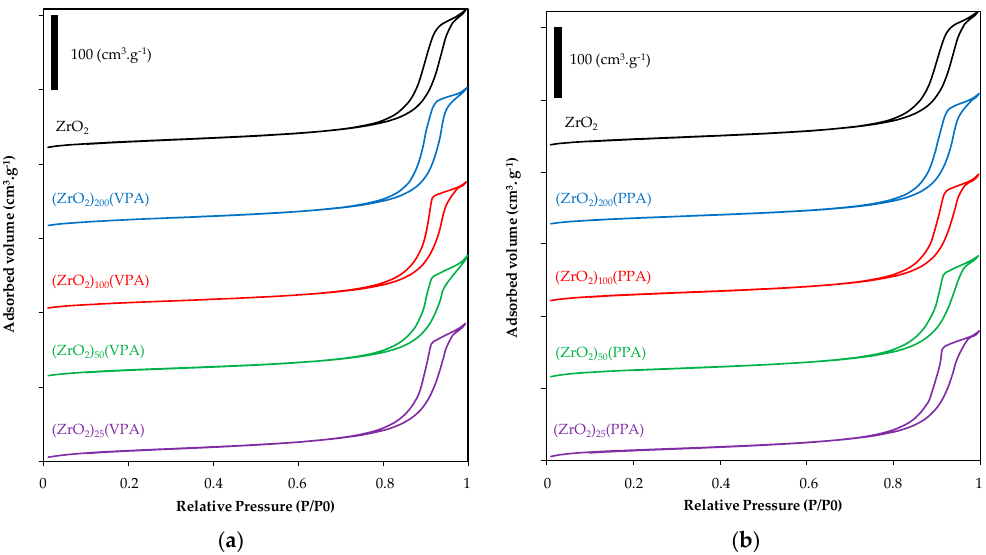
Figure A1. Isotherms of ( a ) (ZrO 2 ) x (VPA) and ( b ) (ZrO 2 ) x (VPA) Samples (Zr/P ratio ( x ) = 25, 50, 100, 200) and bare ZrO 2 .